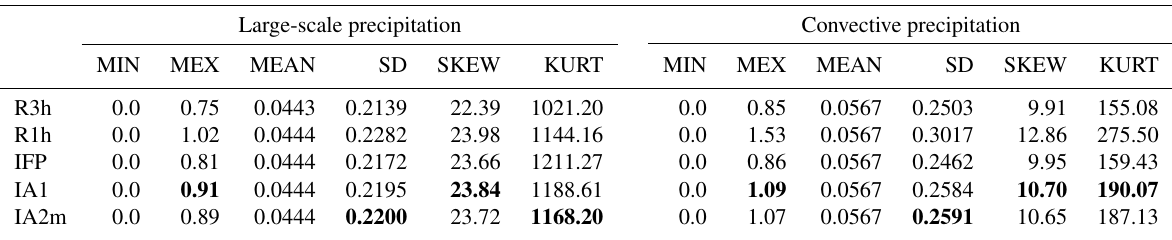
Figure 14. Sample periods in January 2014 at the grid cell centred on 48 ◦ N, 16.5 ◦ W. (a) 11 January 00:00UTC to 13 January 06:00UTC for convective precipitation intensity, and (b) 14 January 00:00UTC to 17 January 00:00UTC for large-scale precipitation intensity. Original ECMWF data are shown as step functions (1-hourly: R1h – dark blue; 3-hourly: R3h – light blue), while the interpolation resulting from the reconstruction algorithms (new algorithms: IA1, orange, and IA2m, red; dashed–dotted, current FLEXPART algorithm: IFP, green) are piecewise linear between the respective supporting points. A baseline is drawn in black at intensity value zero. Table 3. Statistical metrics for the global large-scale and convective precipitation rates (mmh − 1 ) of the ECMWF data set for the year 2014. It comprises the minimum (MIN), mean of event maxima (MEX; see text for definition), mean value (MEAN), standard deviation (SD), skewness (SKEW), and kurtosis (KURT) of the true ECMWF R3h and R1h data as well as of the data reconstructed by the current FLEXPART algorithm IFP and the two new algorithms IA1 and IA2m. Among the reconstructed data, those being closest to R1h have been marked by bold